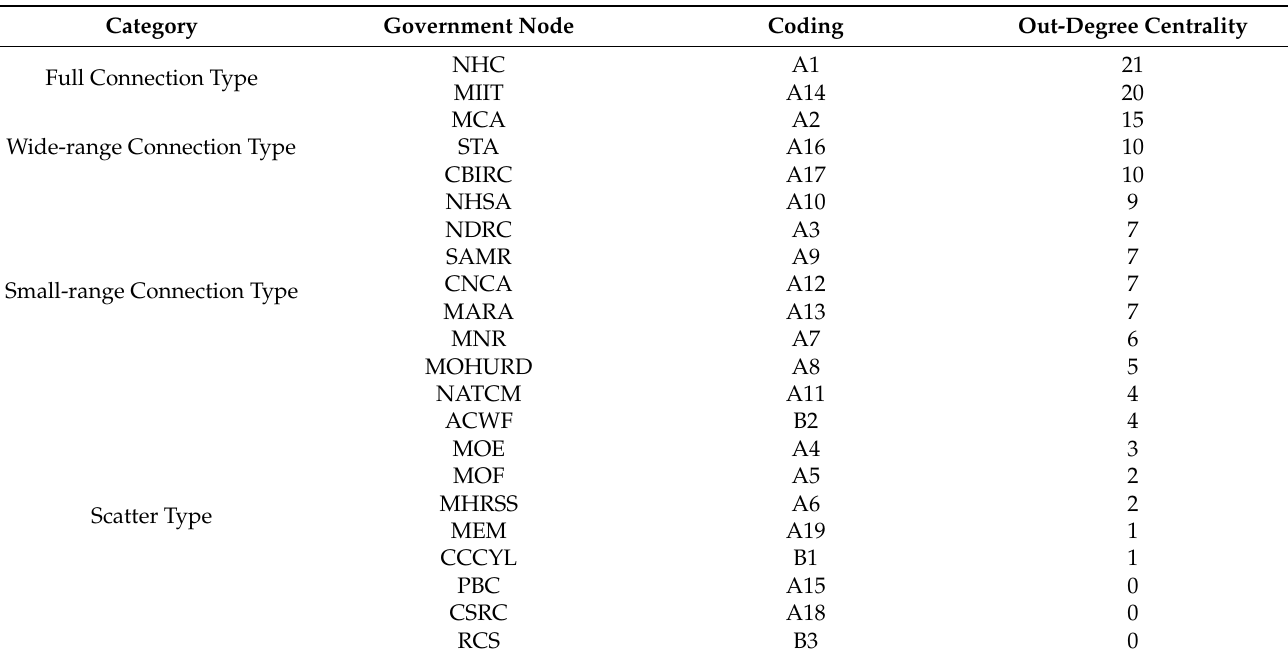
Table 2. The out-degree centrality values of different nodes.